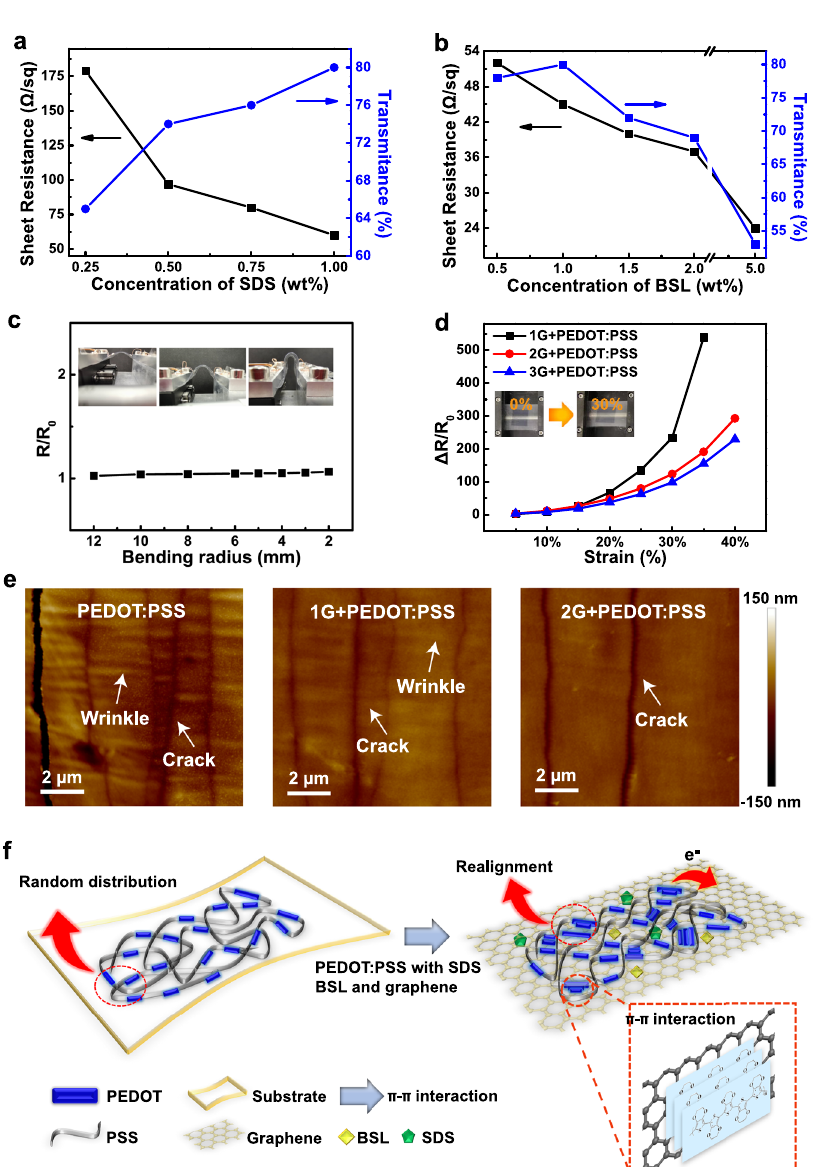
Fig. 2 Optoelectronic performances of PTG. a , b Sheet resistance and transmittance (at λ = 550 nm) of PTG fi lms at various SDS ( a ) and BSL ( b , 1.0 wt% SDS) concentrations when forming PEDOT:PSS carrier layer. c Normalized resistance changes of PTGs on PET at bending radius from 12 to 2 mm, and inset photographs showed PTGs on PET at different bending degrees. d Normalized resistance changes of PTGs on elastic SEBS at various strains. PTGs were made by PEDOT:PSS transferred mono-, bi-, and tri-layer graphene. e Morphological comparison of pure PEDOT:PSS and PTGs (mono- and bi-layer graphene) on SEBS upon 20% strain by AFM. The strain direction is perpendicular to the cracks and parallel to the wrinkles which are generated by Poisson effect. f Schematic illustration of the synergistic enhancement in electrical conductivity by π - π interaction and charge delocalization between graphene